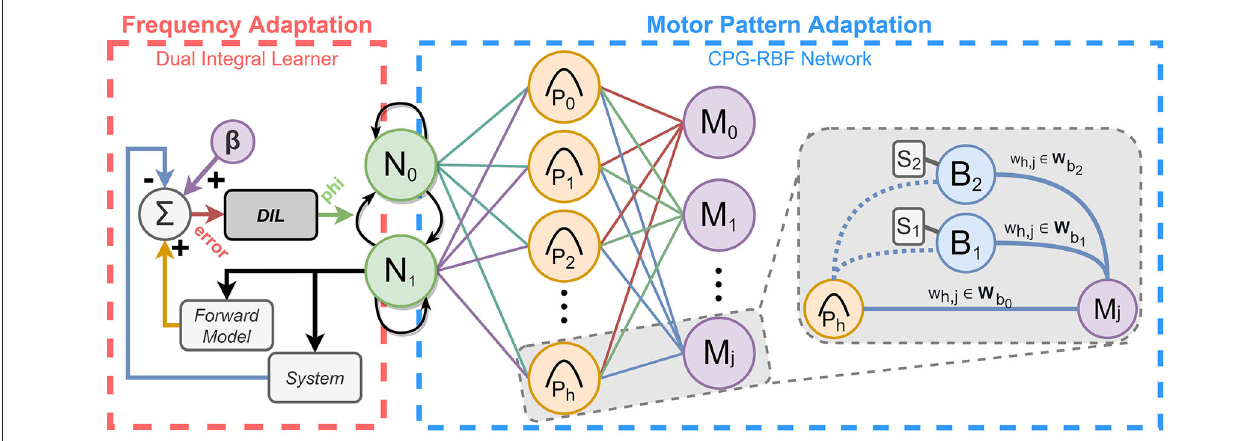
FIGURE 1 | Combining frequency adaptation (DIL) and motor pattern adaptation (CPG-RBF network) into an integrated adaptive CPG-based locomotion